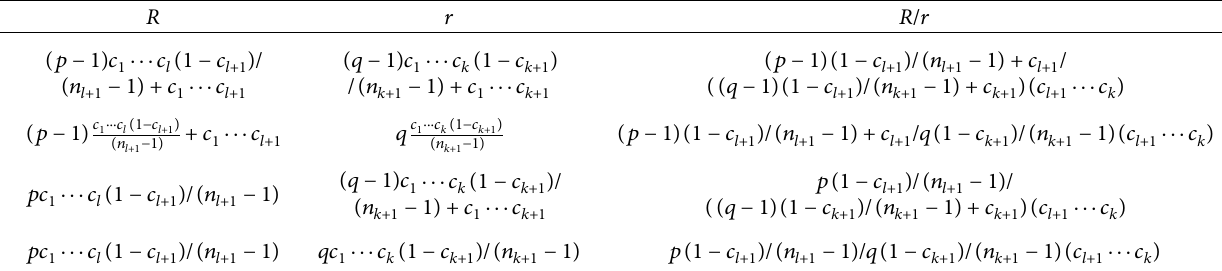
Table 3: The calculation of R / r .